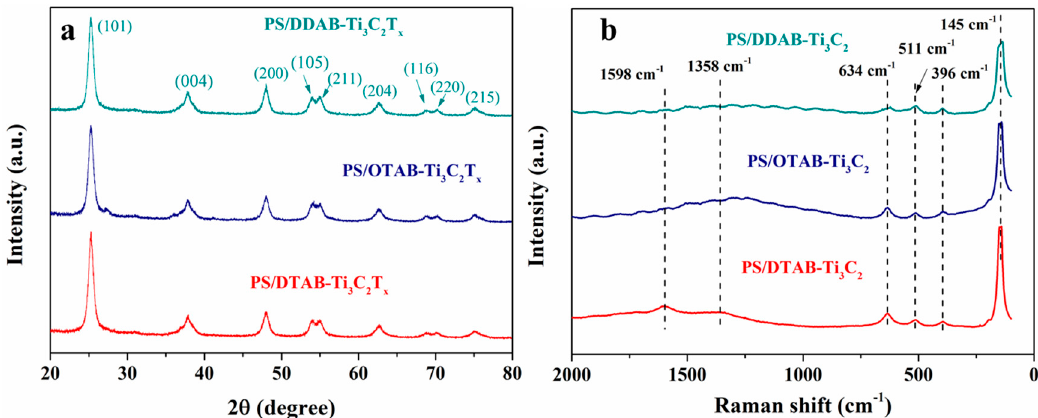
Figure 7. XRD patterns and Raman spectra of the char residues for PS / DTAB-Ti 3 C 2 , PS / OTAB-Ti 3 C 2 and PS / DDAB-Ti 3 C 2 .